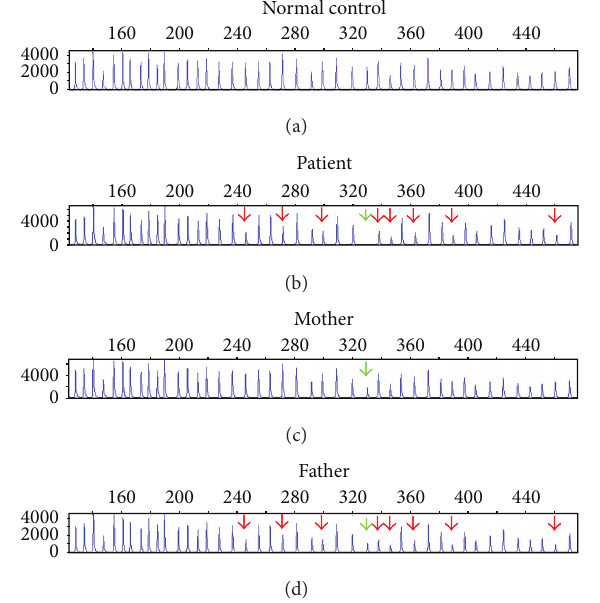
Figure 2: Multiple ligation probe amplification (MLPA) profiles using probe mixture mix P091-C1 CFTR (MRC-Holland). Red arrows showing the same deleted probes in the patient and his father in the CFTR gene. Nine probes are found to be deleted corresponding to a deletion size of 28.7 kb. Green arrows show the p.Phe508WT probe ( CFTR probe 03322-L14978) which in the patient displayed no amplification due to the presence of the exonic deletion and the p.Phe508del